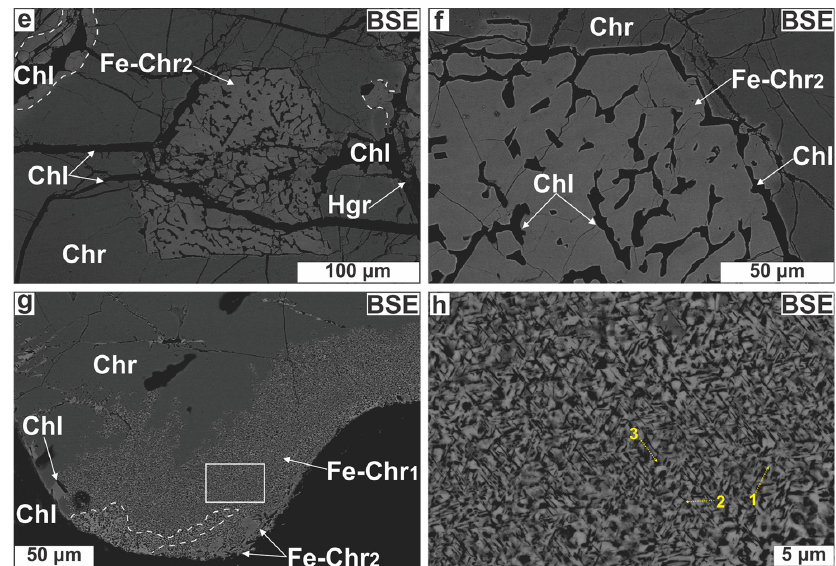
Figure 5. Photomicrographs illustrating Cr-spinel textural modification. ( a ) Chromian spinel surrounded by a dark grey rim; ( b ) The same image in XPL showing that the rim is surrounded by chlorite; ( c ) Chromian spinel almost entirely replaced by a bright (spinel) phase; ( d ) Porous spinel for Cr-spinel substitution; ( e , f ) Spongy spinel displaying elongation of pores; ( g ) Cr-spinel with a boundary made up of spinel mixed with Mg-silicates; ( h ) Close up of the white, open square in ( g ) illustrating the oriented Mg-silicate lamellae micro-texture in Cr-spinel. The intersection of Mg-silicate needles in three directions is also marked. Abbreviations (in order of appearance): Fe-Chr = altered spinel; Chl = chlorite; Fe-Chr 1 = lamellae-rich spinel; Fe-Chr 2 = porous spinel; Hgr =